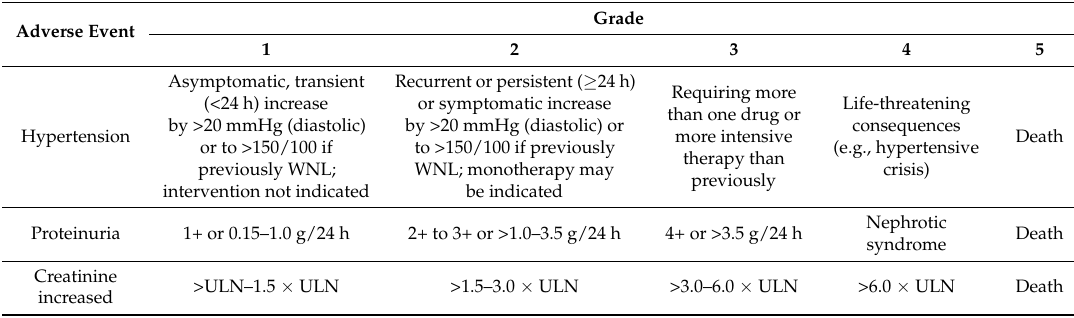
Table 1. Side effects graded according to the Common Terminology Criteria for Adverse Events (CTCAE) version 3.0